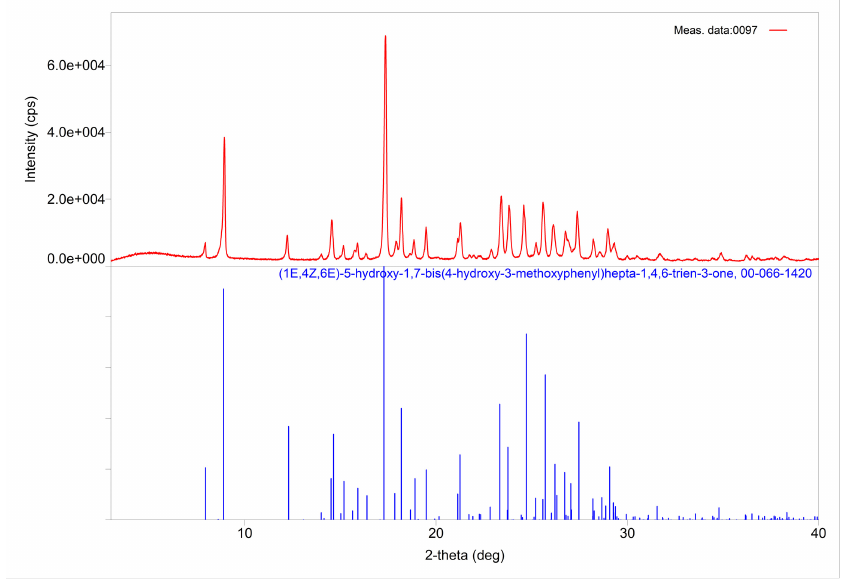
Figure S4: XRPD pattern for bulk curcumin. Reference XRPD pattern for curcumin (card number 00-066-1420; ICDD (PDF-2 Release 2016 RDB)) in blue is below the experimental